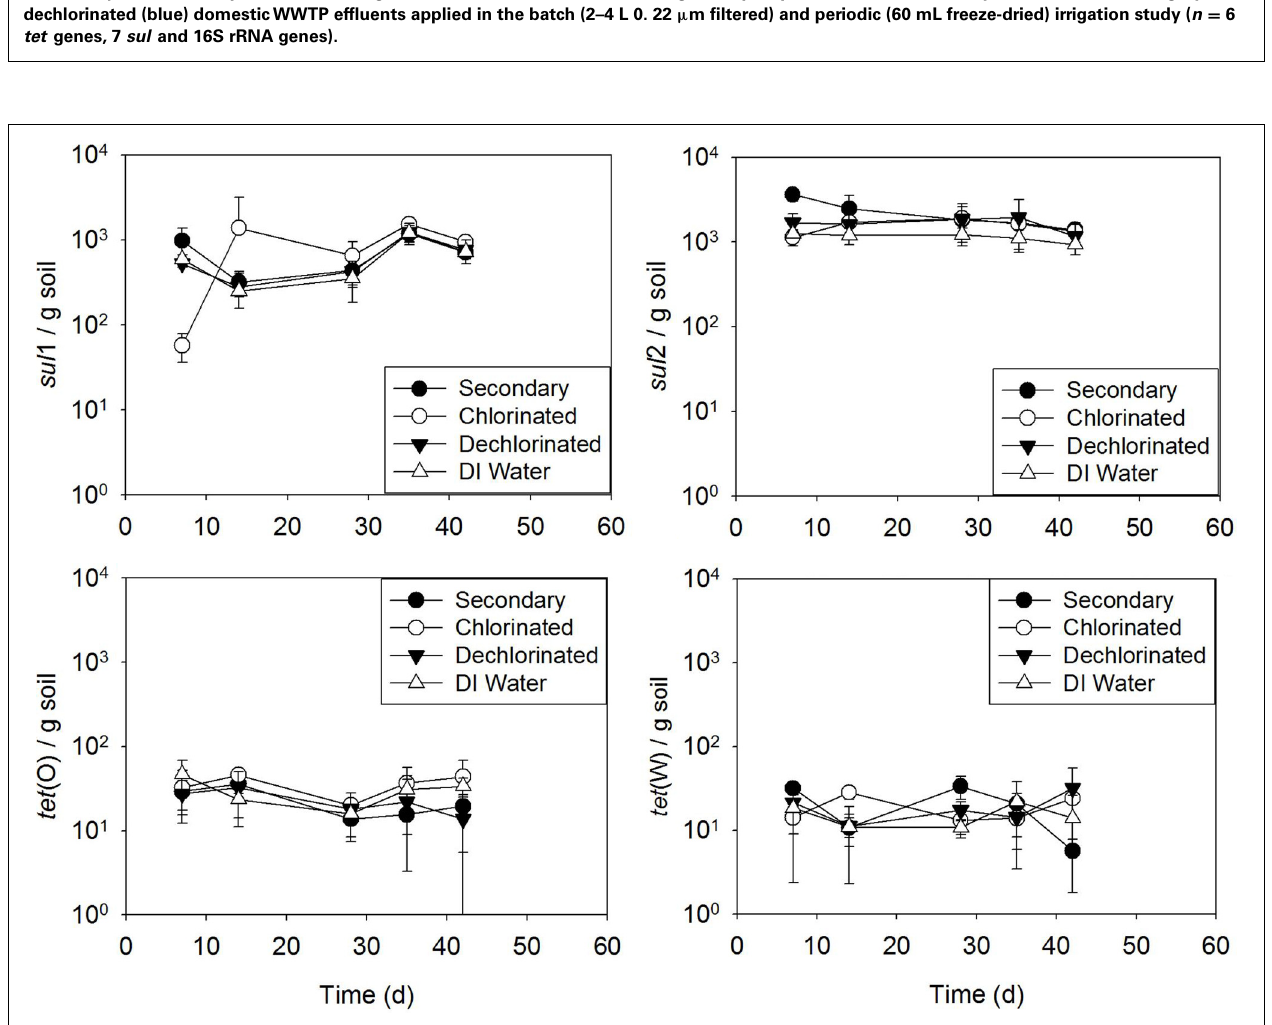
FIGURE 6 | sul 1, sul 2, tet (O), and tet (W) genes in soils subject to one time (batch) irrigation with secondary, chlorinated, dechlorinated domestic WWTP effluents and deionized (DI) water, per gram of soil (slurry). Error bars represent standard deviation of triplicate microcosms.